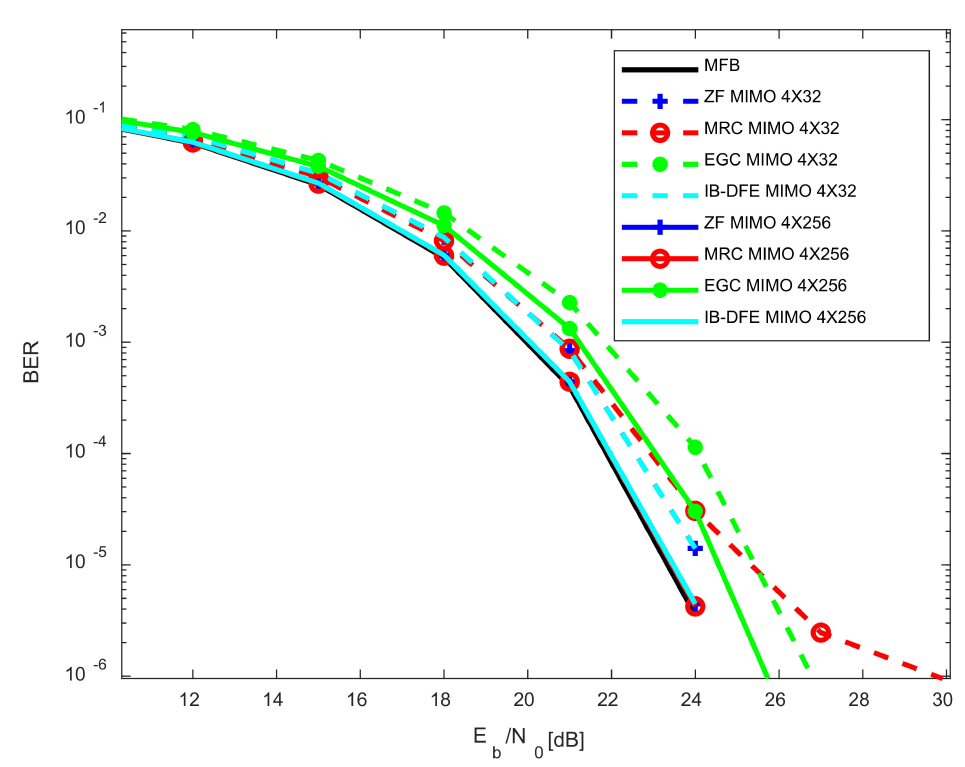
Figure 9. Results for 4 × 32 MIMO versus 4 × 256 MIMO, LDPC codes, impulsive noise, channel estimation, and channel correlation 0.3 between antenna